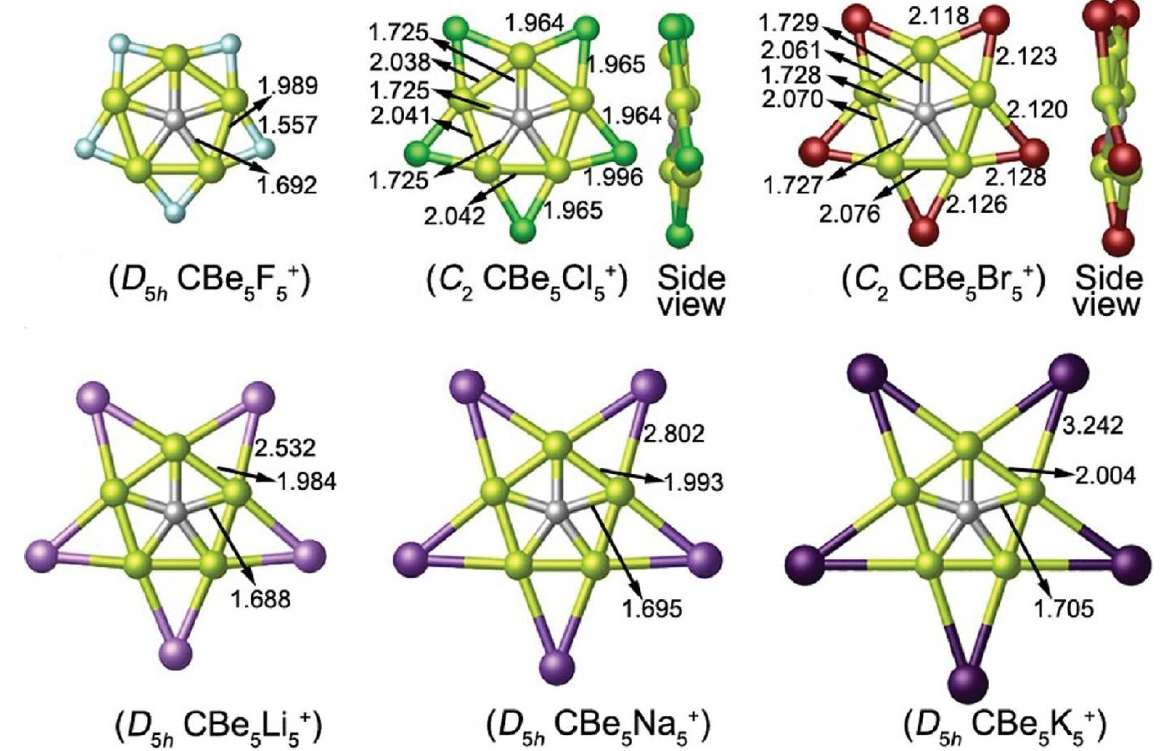
Figure 23. Optimized global-minimum structures of CBe 5 X 5+ (X = F, Cl, Br, Li, Na, K) clusters. Bond distances are indicated in Å. Adapted from ref. [114] with permission from AIP Publishing.